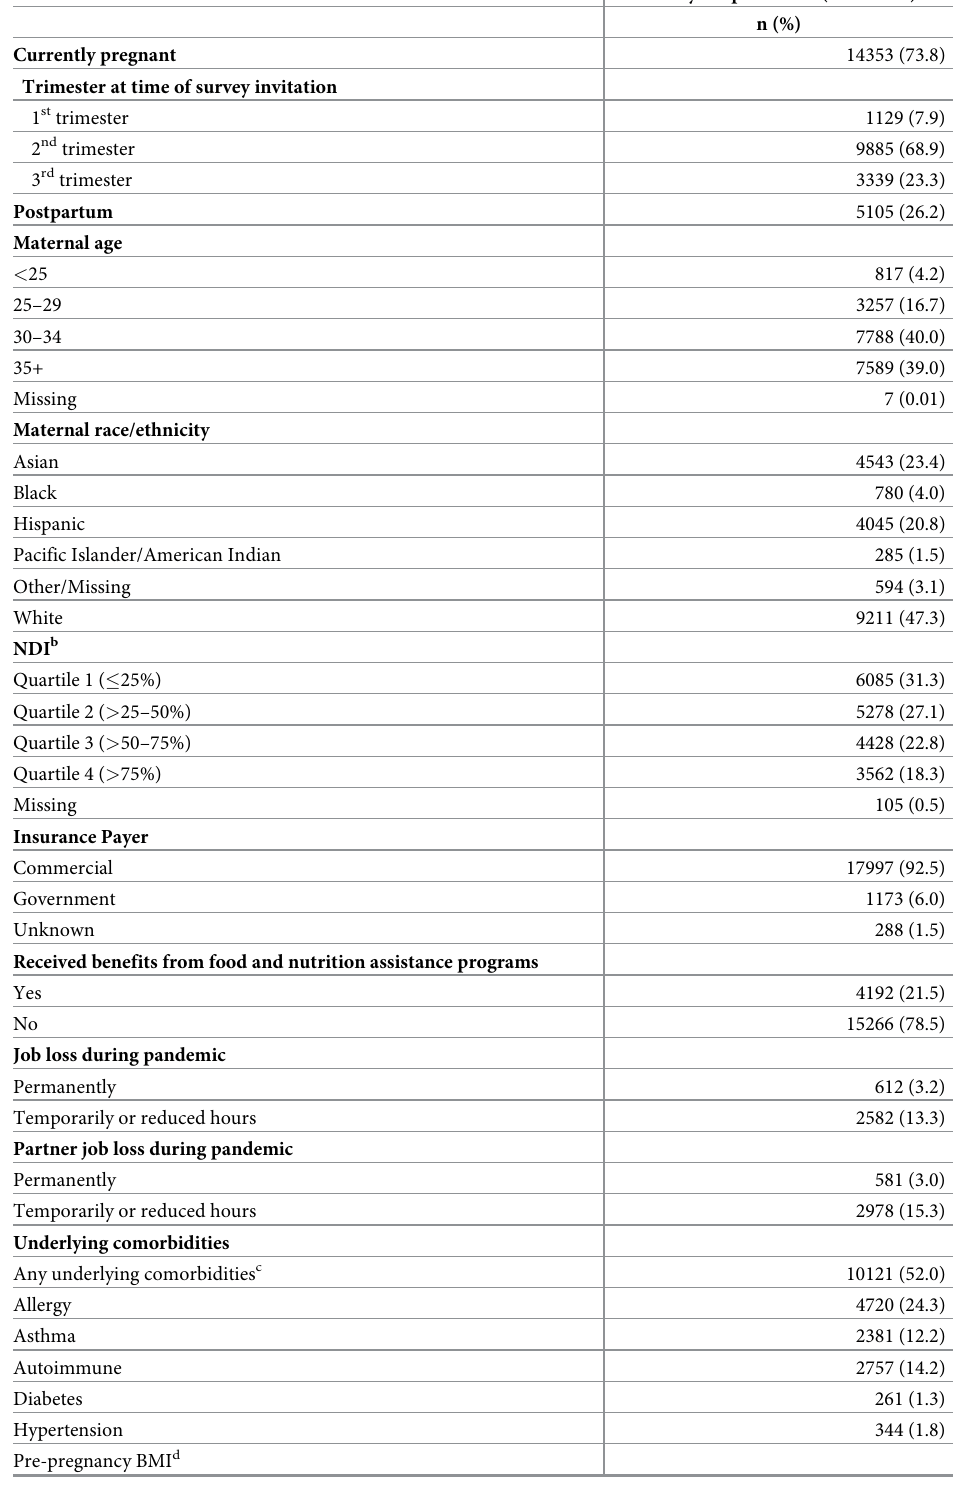
Table 1. Characteristics of survey respondents, Kaiser Permanente Northern